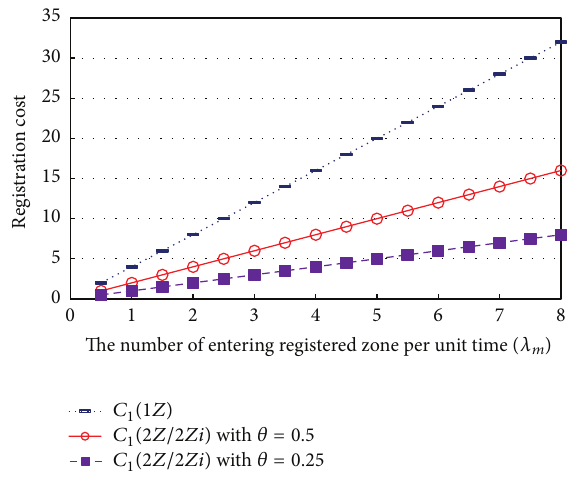
Figure 3: Location registration cost with respect to 𝜆 𝑚 .